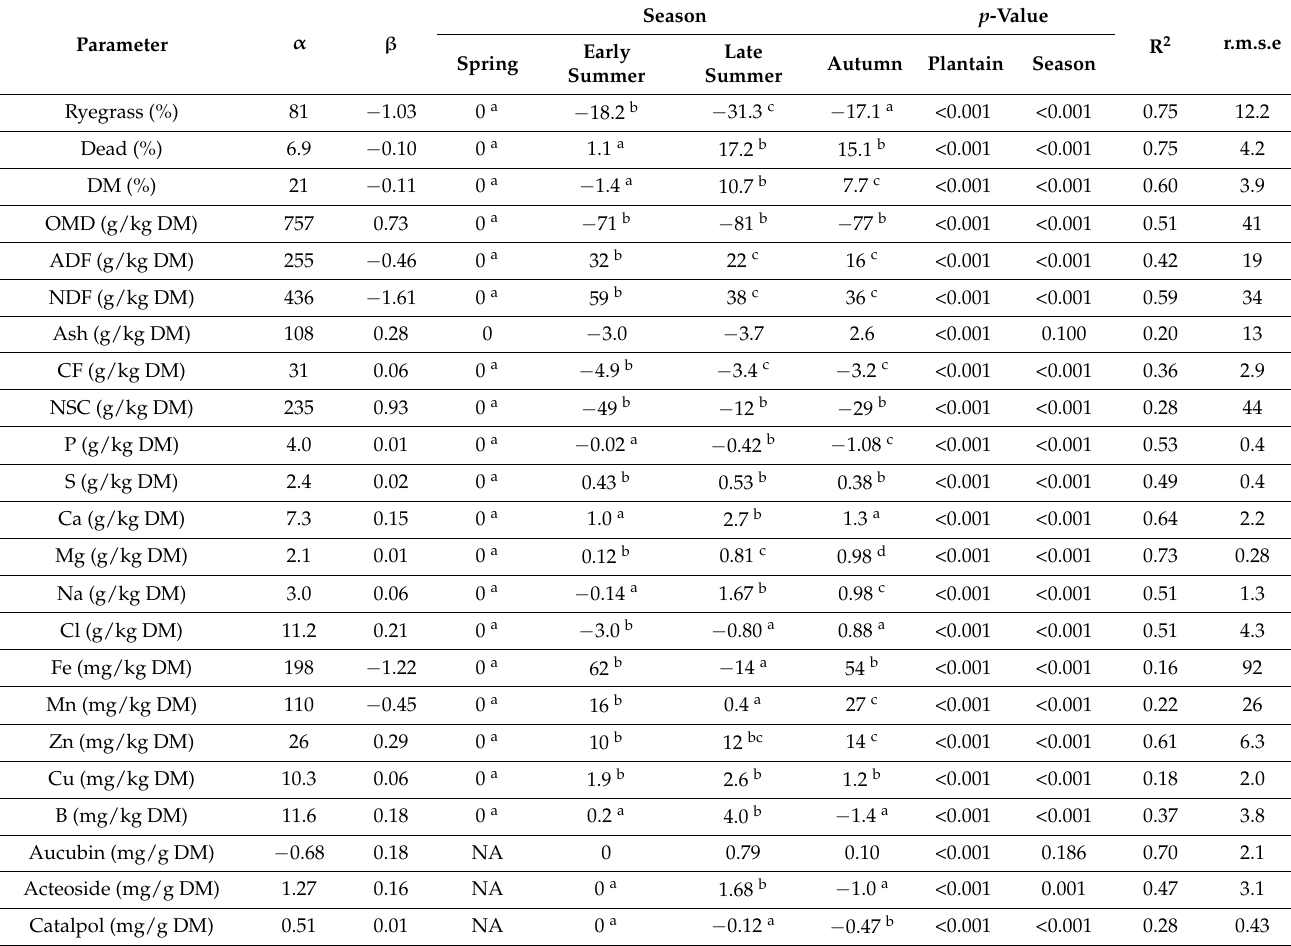
Table 5. Relationship between the content of plantain leaves (%) and parameters related to botanical composition, nutritive value, mineral content, and bioactive compound in spring, early summer, late summer, and autumn between September 2019 and March